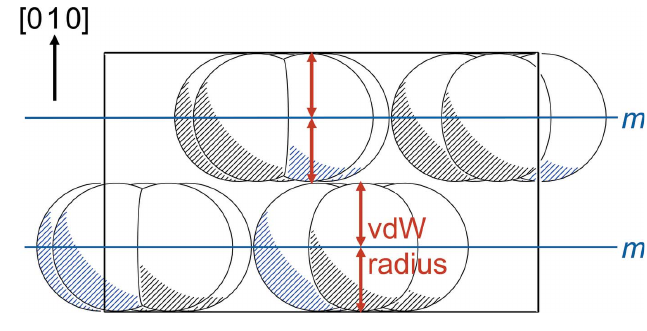
Figure 5 View of the unit cell of 1 along c (Spek, 2020), methyl groups omitted.